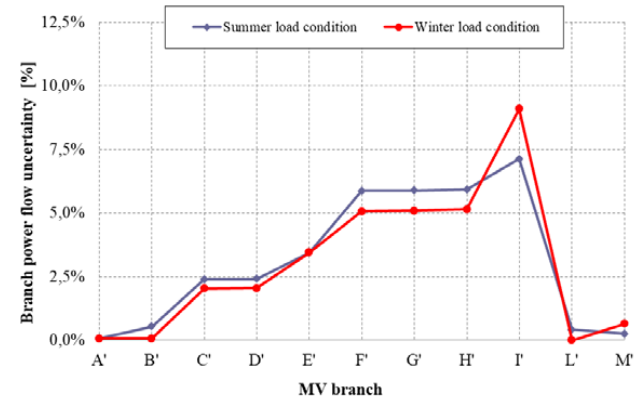
Figure 10 . Branch power flow uncertainty with six PMs located in the AUSL feeder: comparison between summer and winter load conditions.